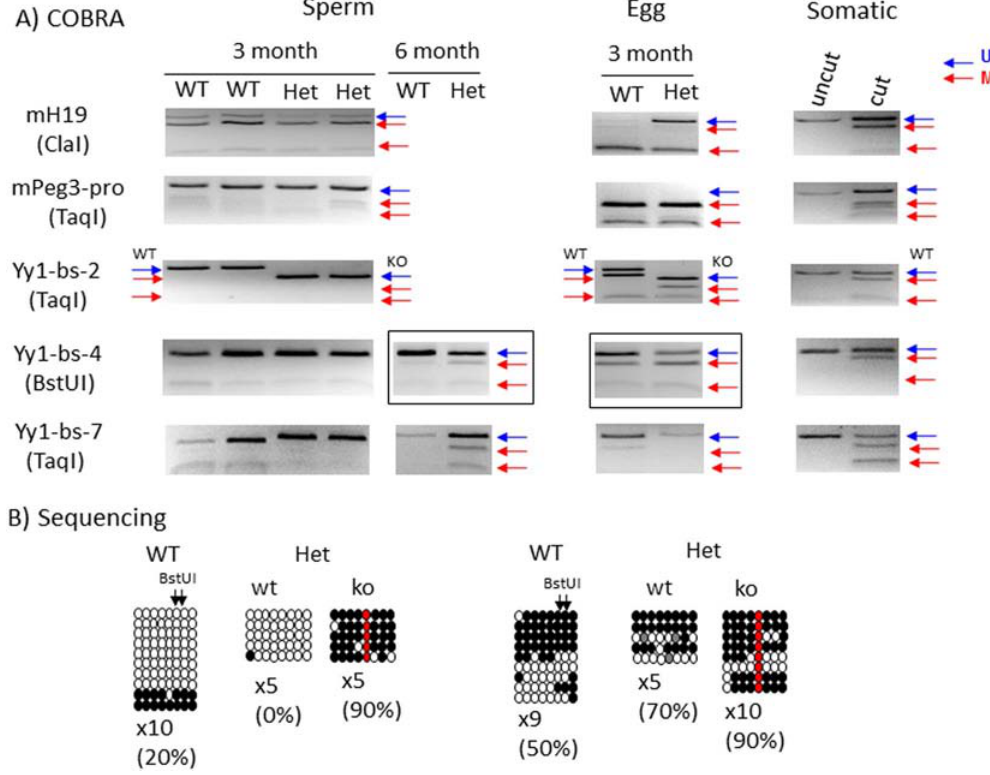
Figure 3. Mutational effects on DNA methylation levels. ( A ) A series of DNA methylation analyses were performed using the DNA isolated from sperm and mature oocytes. The DNA isolated from germ cells was treated with the bisulfite conversion protocol, and subsequently used for the amplification of each target region. The amplified PCR product was analyzed with COBRA. The restriction enzyme used for each set of PCR products is shown underneath of the name of each target. The unmethylation and methylation based on the digestion pattern by a given restriction enzyme are also indicated by blue and red arrows, respectively. This series of COBRA analyses also included somatic DNA as a control set of DNA, which can monitor the proper execution of the experiments. The DNA methylation levels of the H19-ICR were used as an internal control monitoring the purity of sperm and egg. The H19-ICR is mostly methylated in sperm whereas unmethylated in egg. The PCR products from sperm and eggs by the Yy1-bs-4 set, which were marked with boxes, were further analyzed by individual sequencing. These results are shown in ( B ). The sequencing results from these products were summarized in the following manner. Each row represents one sequence read while each circle within this row indicates one CpG dinucleotide. The open and close circles indicate the unmethylated and methylated CpG sites, respectively. The red circles indicate the CpG site within #4 YY1 binding site, which has been mutated to a non-CpG dinucleotide. The gray circles indicate the CpG sites with ambiguous base-calling. This mutation was used to separate the sequence reads into two groups, the mutant (ko) and wild-type (wt) alleles. The ‘X’ in 5X or 10X indicates the number of clones that were sequenced after the cloning of each PCR product. The percentage values indicate the methylation levels that have been measured by sequencing. In this set of DNA methylation analyses, we were not able to amplify one PCR product, one by mH19 primer set from the WT egg. Also, the sizes of some of the final products are different between WT and KO due to the inclusion of a loxP site between two primers, the products by the Yy1-bs-2 and Yy1-bs-7 primer sets. In the case of Yy1-bs-2, a separate primer set targeting the KO allele was used for the Het samples of both sperm and eggs, thus generating a different-size product. The original gel images for the gel pictures are available as Supplemental material